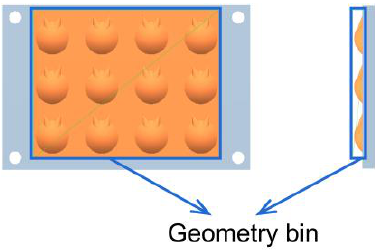
Figure 10. Geometry bin for analysis divided from geometry region. Table 2. Averaged abraded depth.